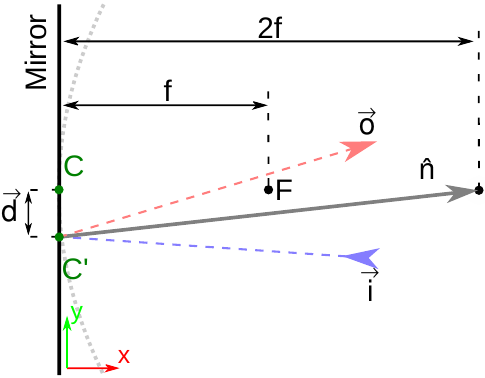
Figure A1. Calculation of offset d , between the observed point C (cid:48) and the actual center C of the mirror, given the incoming and reflected rays (cid:126) i and (cid:126) o and the focal length f of the concave mirror. While the DDHOE represents a concave mirror, the actual surface of the DDHOE is flat. As such, we model the DDHOE as a flat surface with a surface normal ˆ n that behaves like a concave